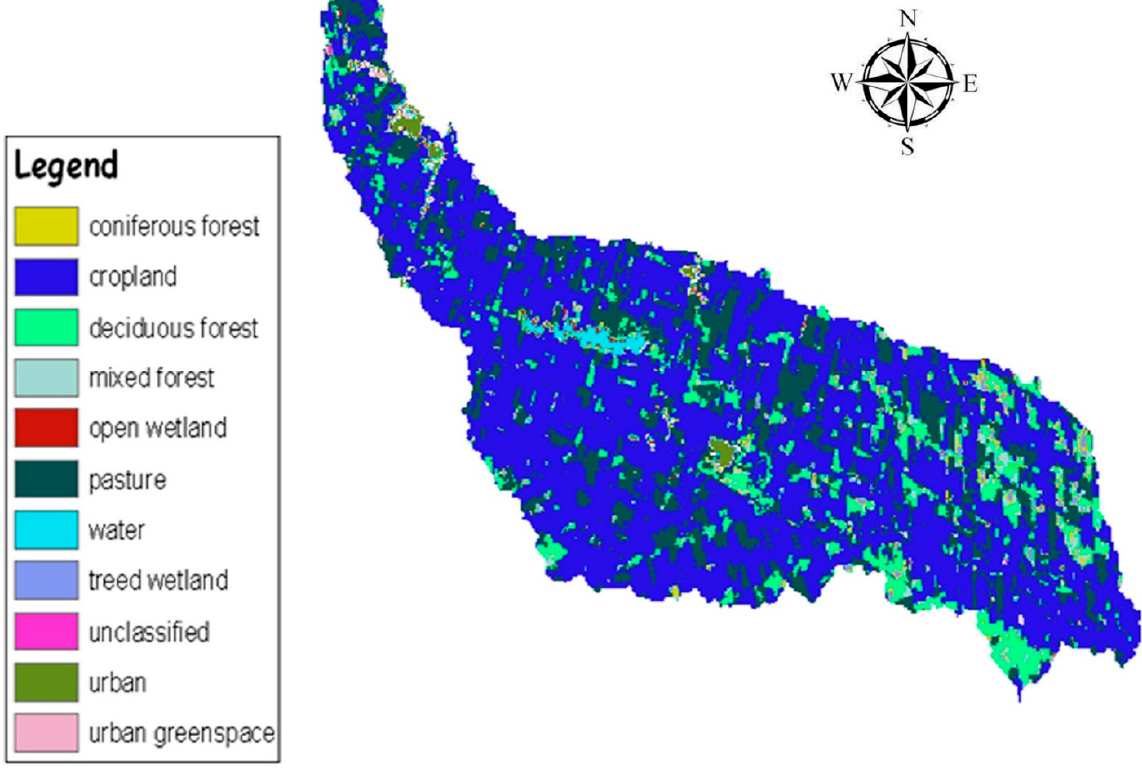
Figure 4. Land use for the Upper Welland River